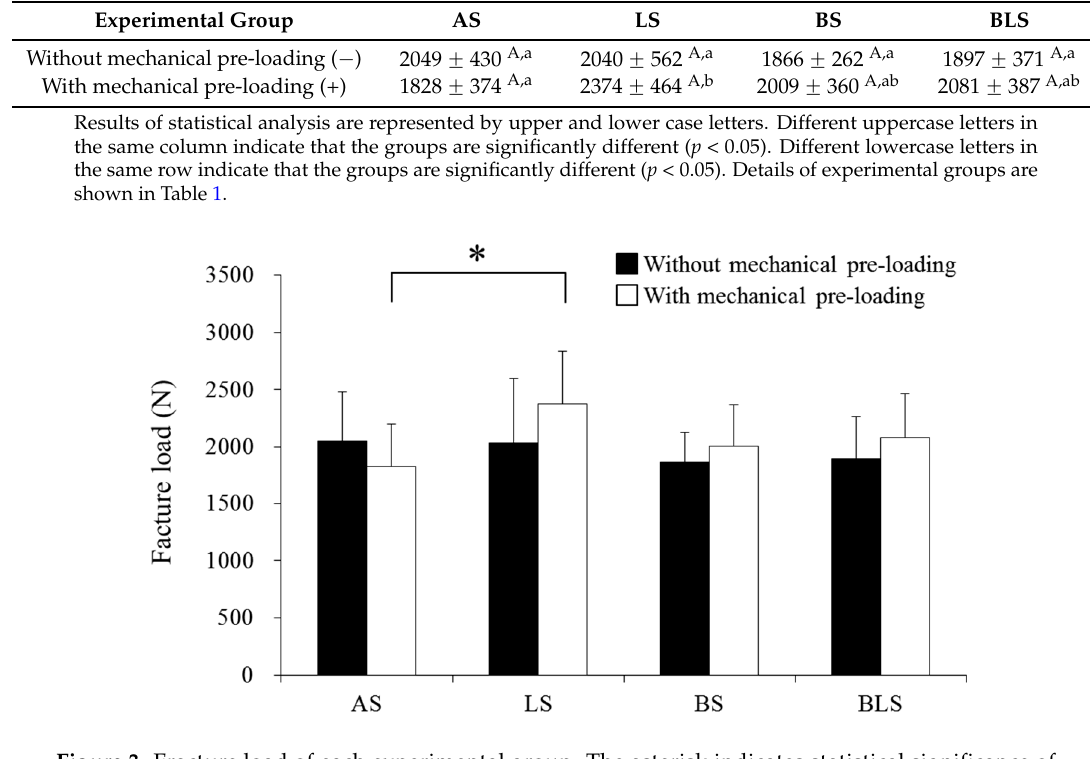
Figure 3. Fracture load of each experimental group. The asterisk indicates statistical significance of difference between groups ( p < 0.05). Details of experimental groups are shown in Table 1.